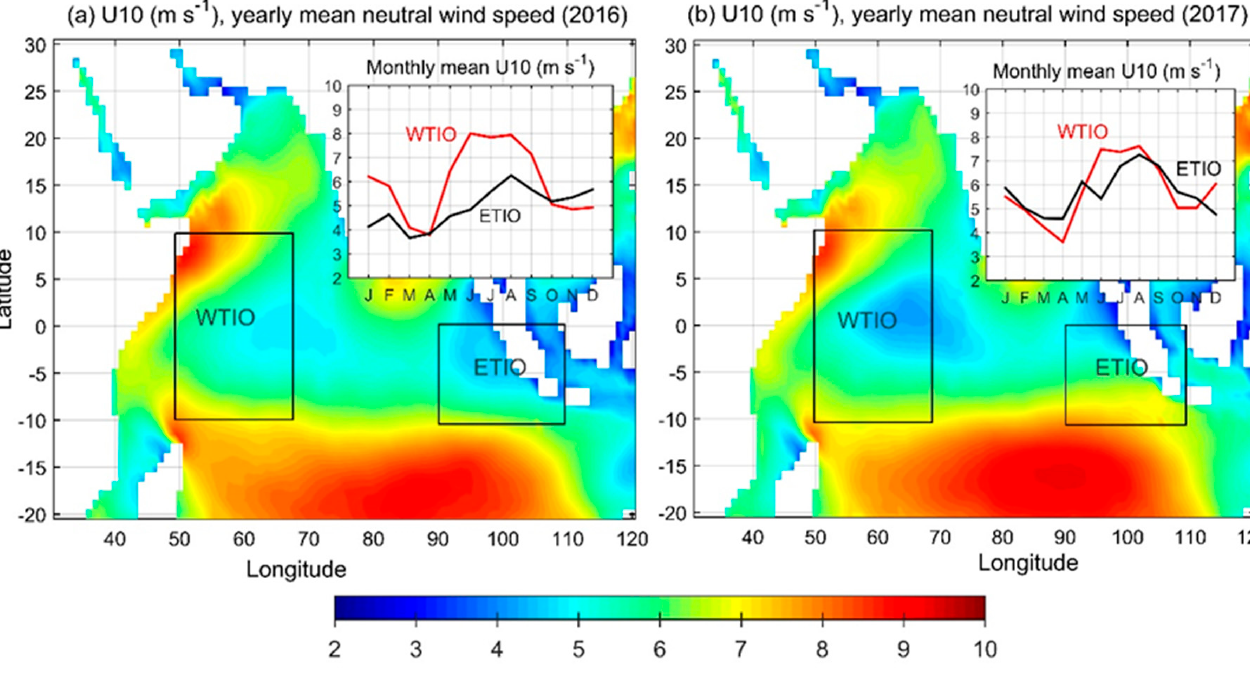
Figure 8. As in Figure 6, but for neutral wind speed at 10 m above sea surface (U10) in 2016 ( a ) and 2017 ( b ). Data provided by the WHOI OAFlux project.